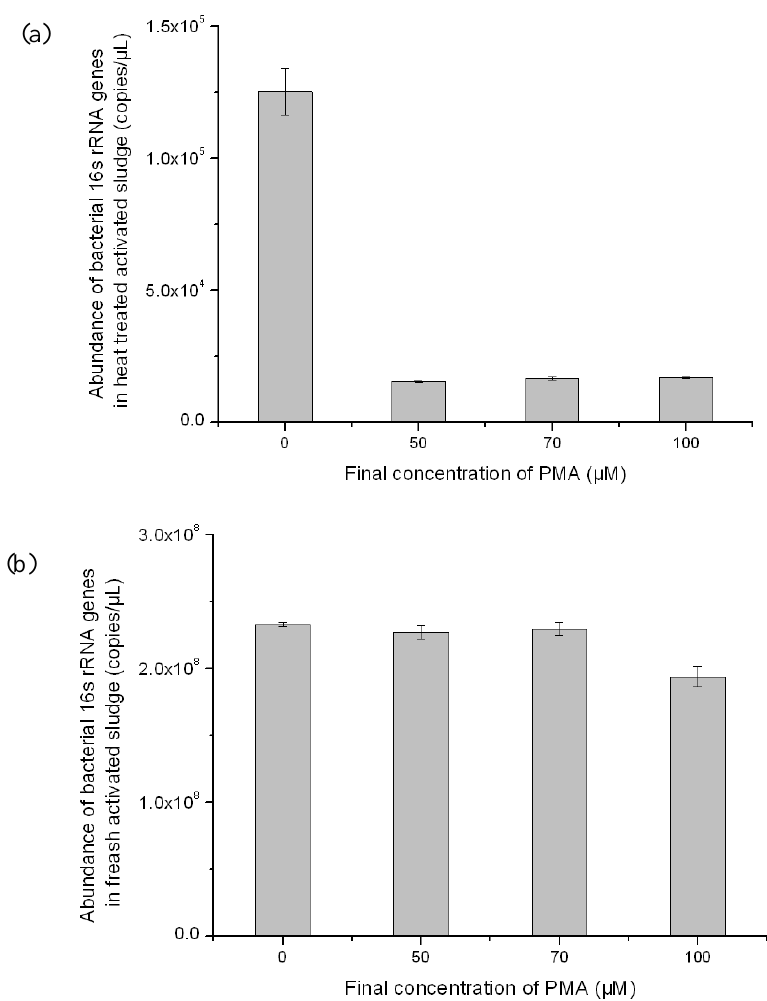
Figure 2. Effect of final PMA concentrations on quantitative polymerase chain reaction (qPCR) quantification of bacterial 16S rRNA gene: ( a ) fresh activated sludge; and ( b ) heat treated activated sludge.